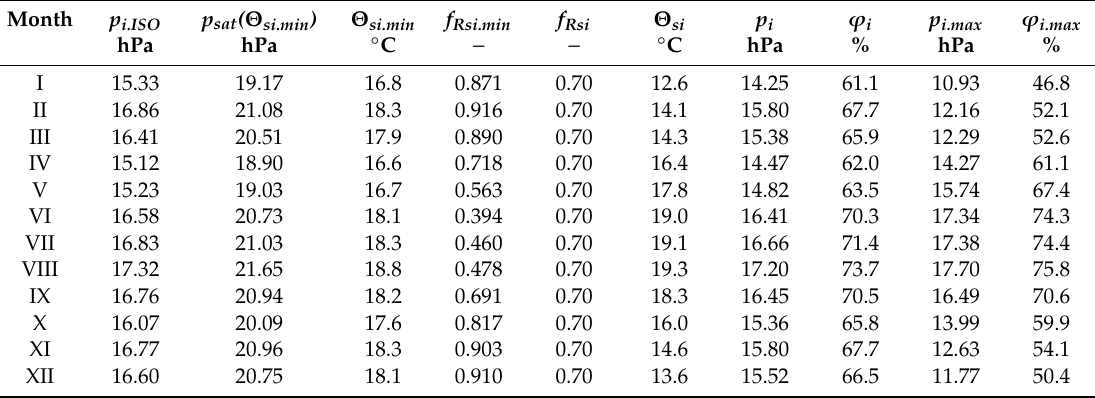
Table 6. Parameters for mold development characteristics for four